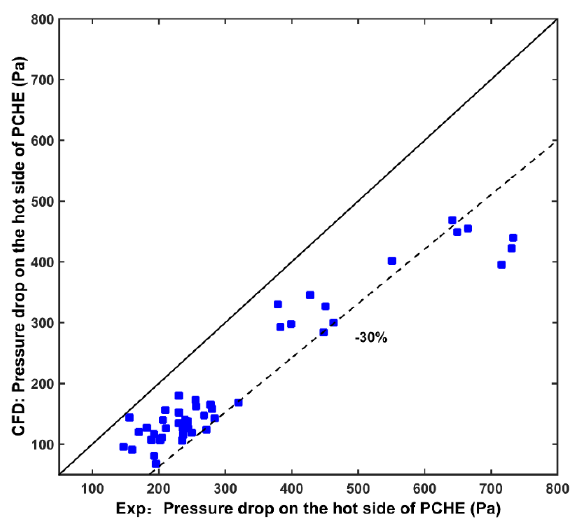
Figure 11. Deviations between the numerical and experimental pressure drops.